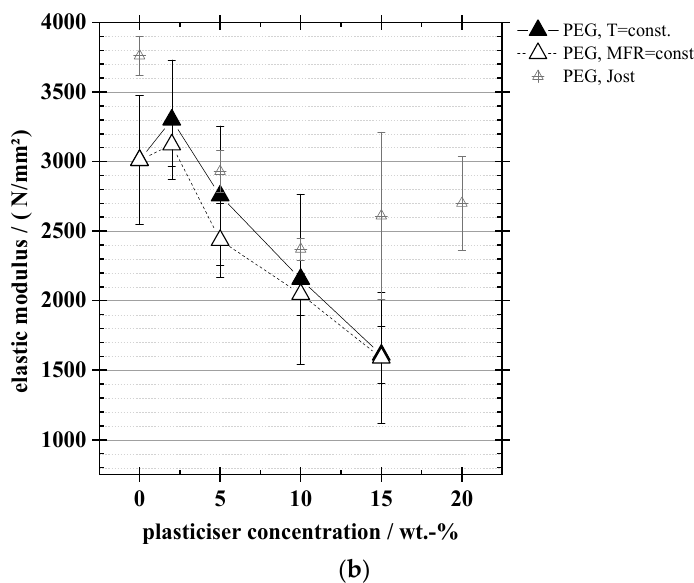
Figure 9. Elastic modulus as function of plasticizer concentration: ( a ) of triethyl citrate (TEC) concentration; ( b ) of polyethylene glycol (PEG) concentration. Comparison with results of Jost. MFR: melt flow rate during extrusion; T: temperature during extrusion.